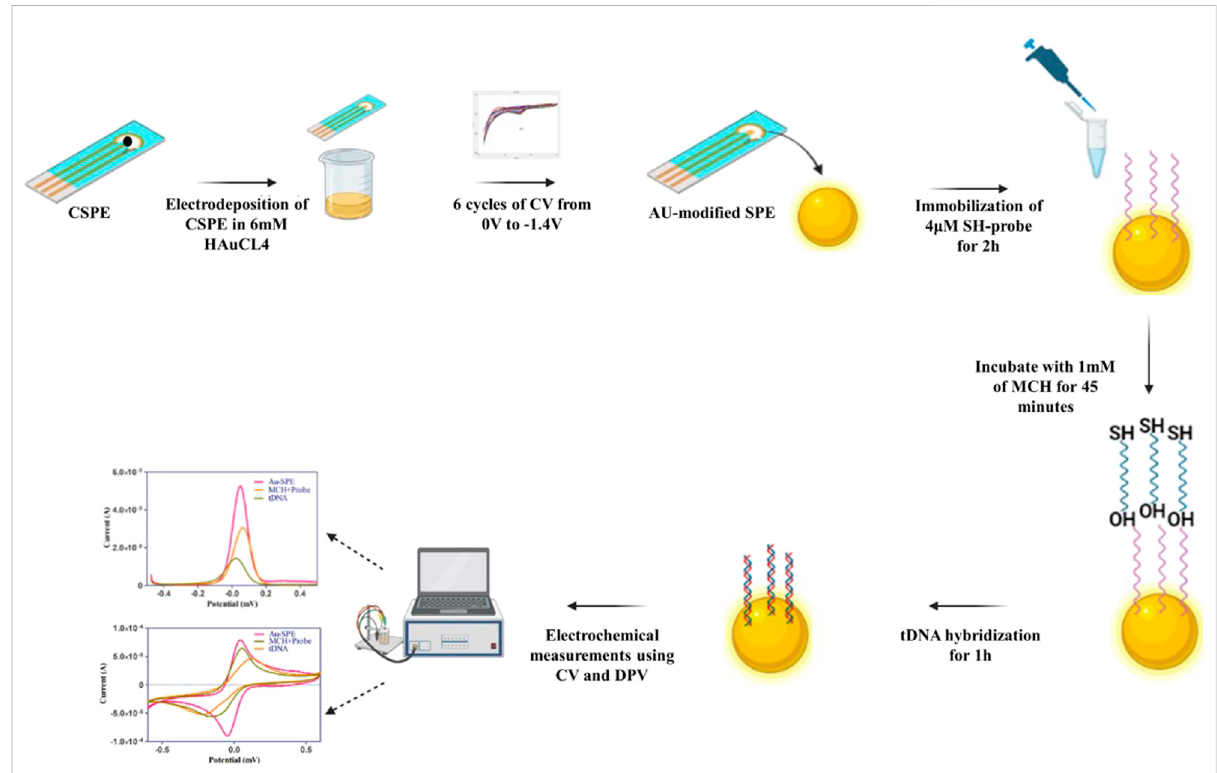
FIGURE 1 Schematic illustration of stepwise modi fi cation of screen-printed electrode for the detection Mtb DNA.